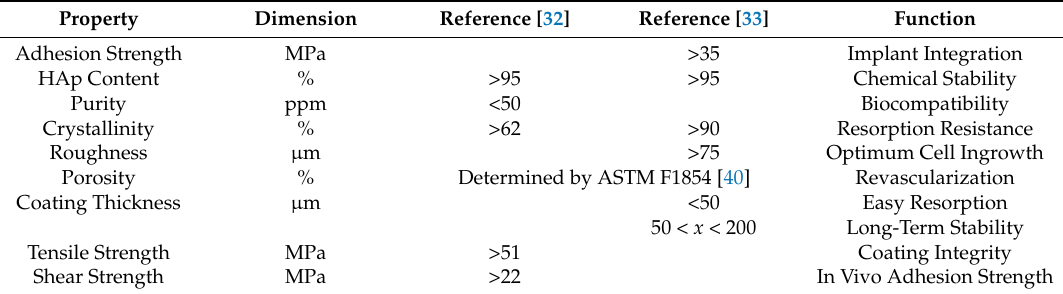
Table 1. Property profile of plasma-sprayed hydroxylapatite (Hap) coatings